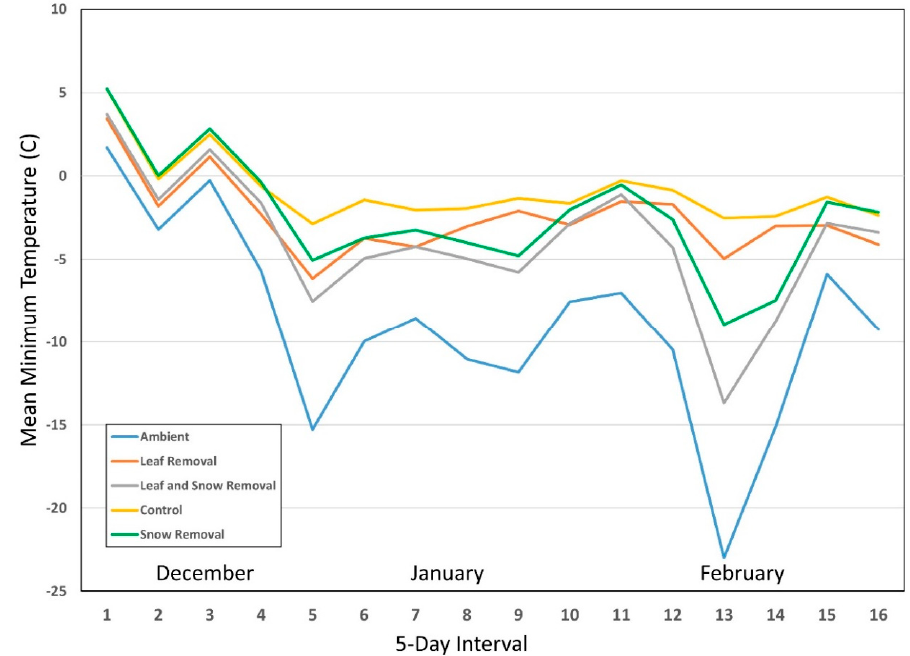
Figure 1. Year 1 mean minimum temperatures (°C) for all four treatment types and ambient temperature for 5-day intervals starting from mid-December through to the end of February for Connecticut and Maine combined.